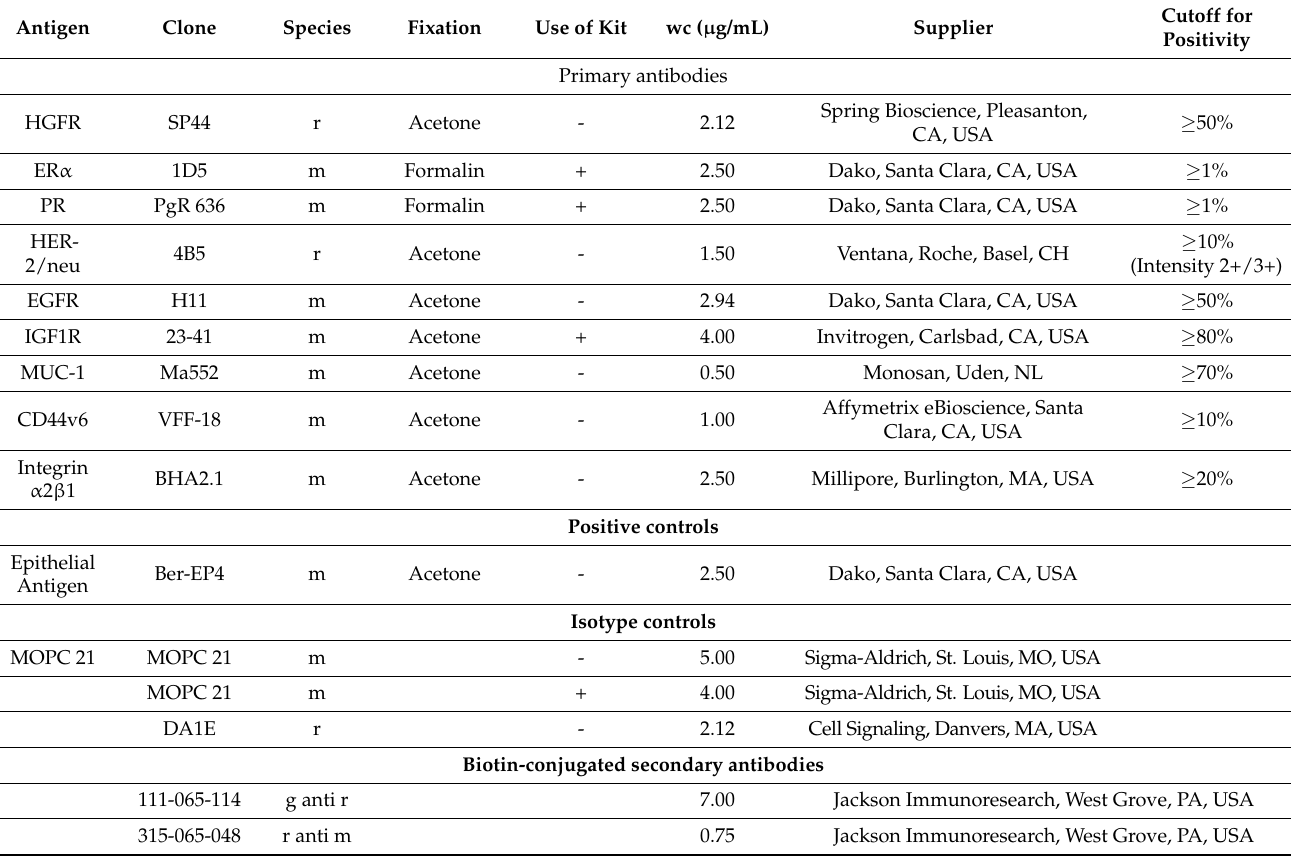
Table 1. Biomarkers and